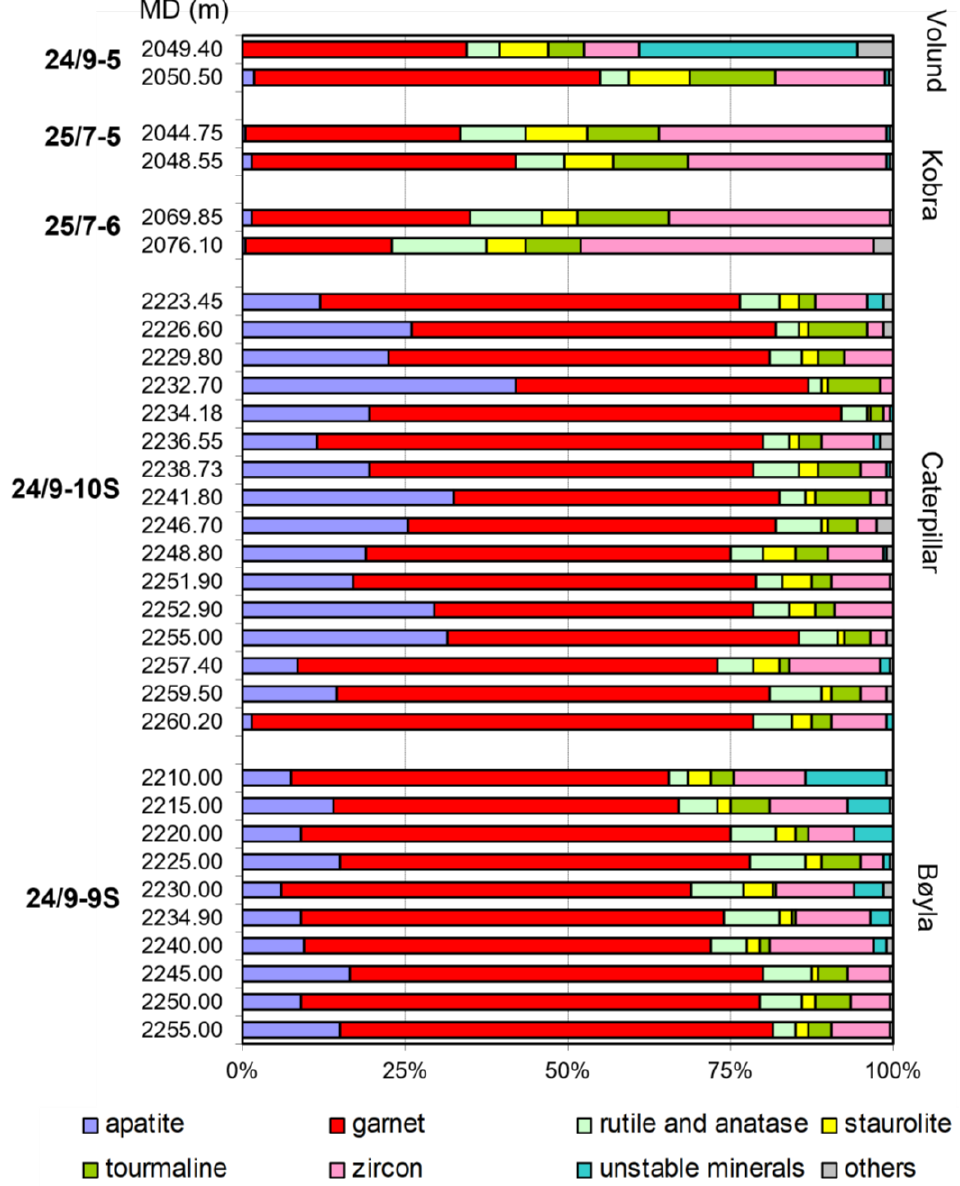
Figure 5. Heavy mineral assemblage compositions in the Hermod S2 Mbr in the Caterpillar dis- covery well, 24/9-10S, compared with equivalents elsewhere in the Greater Alvheim area. Note the markedly lower apatite and garnet contents and the correspondingly higher zircon, rutile and tourmaline abundances in the Volund and Kobra wells compared with Bøyla and Caterpillar, and also the high abundances of unstable minerals in one Volund sample. “Unstables” are amphibole, epidote and pyroxene. “Others” are allanite, corundum, chloritoid, gahnite, kyanite, monazite, sillimanite, titanite and xenotime.